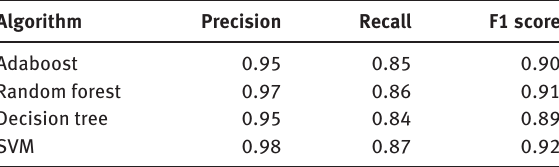
Table 2: Precision, Recall, and F1 Score of Different Classifier Algorithms on Our Dataset. Algorithm